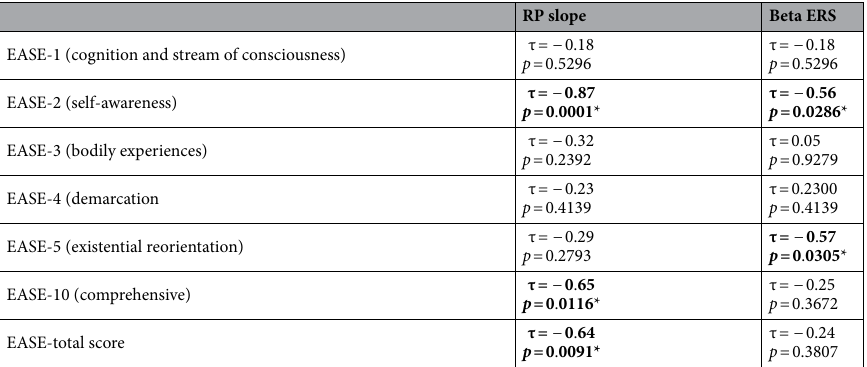
RP slope Beta ERS